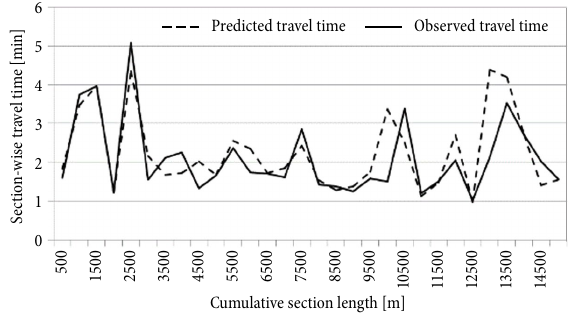
Fig. 7. Observed and predicted bus travel time for off-peak trip